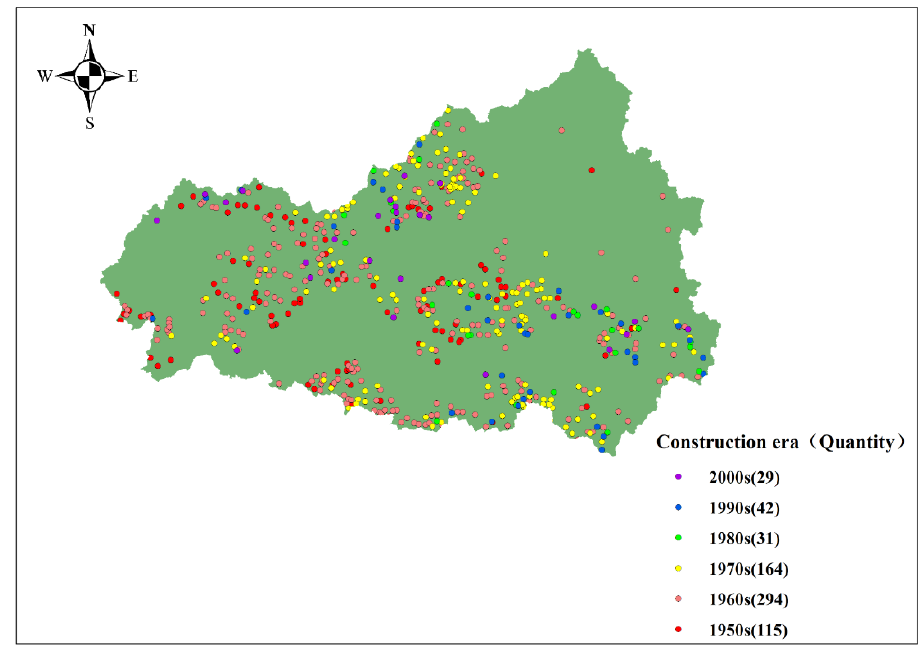
Figure 14. Distribution of new reservoirs in the Dawen River Basin during the study period.